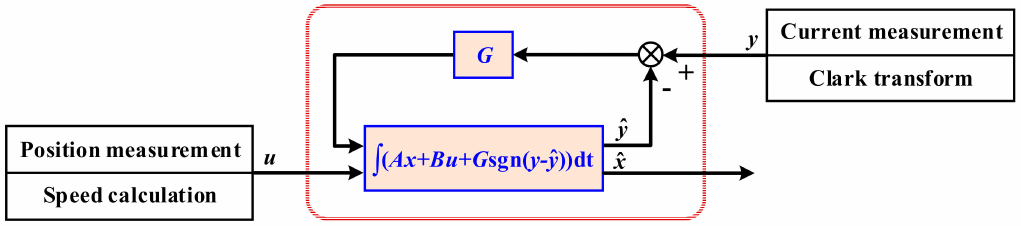
Figure 5. Schematic diagram of sliding mode observer